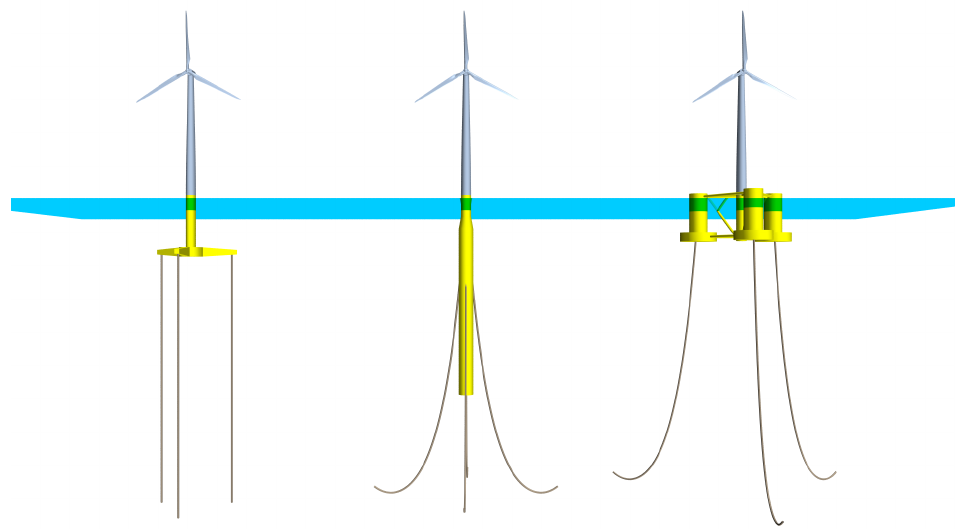
Figure 13. Typical mooring systems installed on different FWTs with TLP type ( left ), Spar type ( middle ), and semi-submersible type ( right